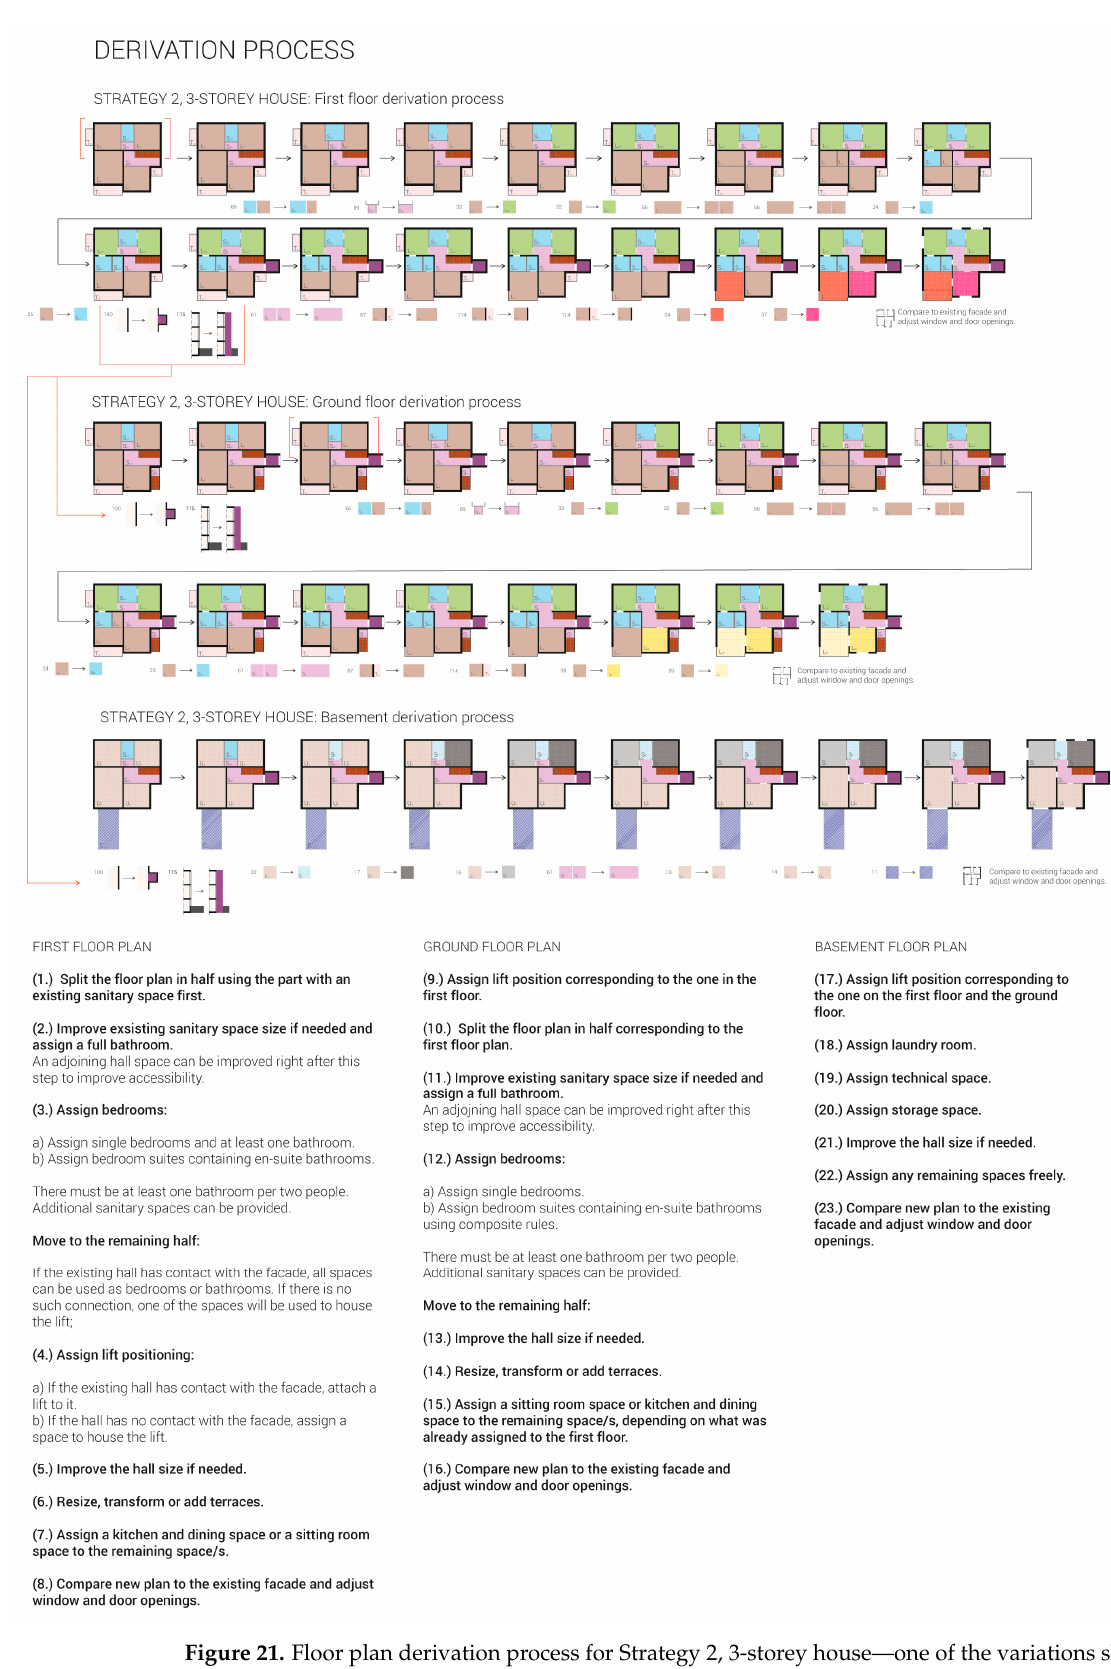
Figure 21. Floor plan derivation process for Strategy 2, 3-storey house—one of the variations shown in Figure 22 (Ana Belˇciˇc,